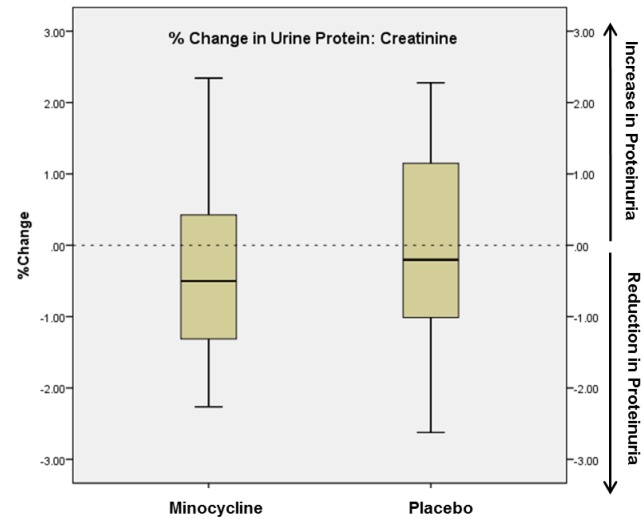
Percent change in 24-hour urine protein/creatinine measurements from baseline to 6 months in placebo and minocycline groups.The edges of the boxes represent the 25% and 75% percentiles, the middle lines represents the median, and the whiskers extend to the minimum and maximum values. The primary outcome, ln (6Month P:Cr/baseline P:Cr), was not significantly different between the groups (p = 0.27).